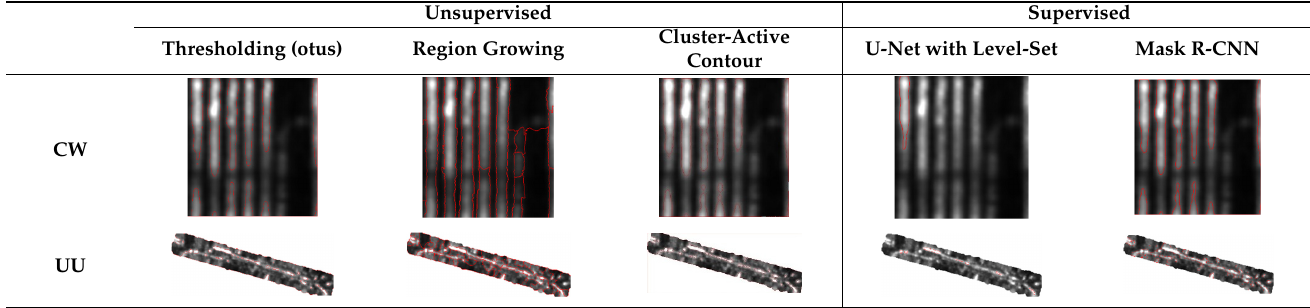
Table 2. Comparison of different image segmentation methods.